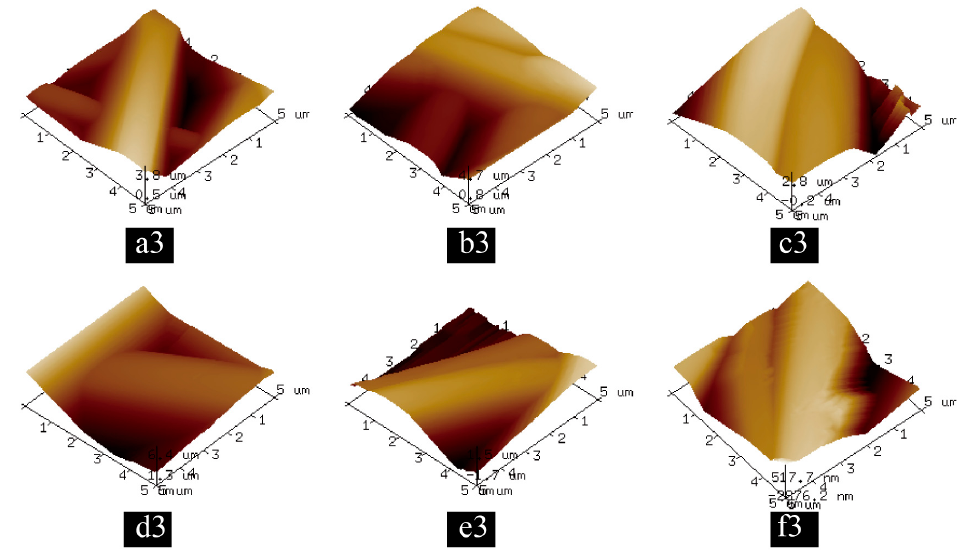
Figure 5. 3D topography AFM images of PLA nanofibers along with different mineralization time: ( a3 ) 0-day; ( b3 ) 1-day; ( c3 ) 3-day; ( d3 ) 5-day; ( e3 ) 7-day; ( f3 ) 21-day.